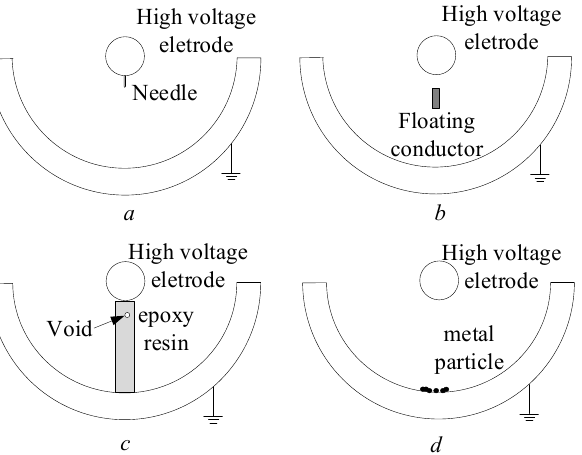
Figure 1. PD defect model of GIS. ( a ) metal tip defects, ( b ) floating electrode defects, ( c ) insulating void defects, ( d ) free metal particle defects.